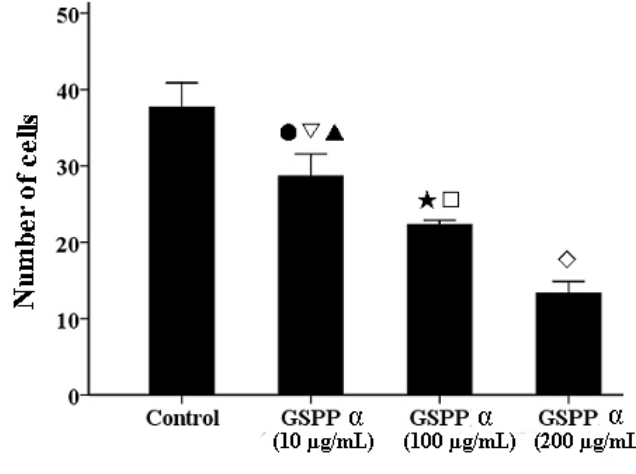
Figure 5. Transwell assay of Gekko sulfated glycopeptides on SMMC-7721 cells. After staining with crystal violet, cells that had penetrated through the chamber were counted using a light microscope. Each bar showed the number of cells that had penetrated through the chamber ( P < 0.001). The values represent means ± SD. ● versus control group, P = 0.001; ▽ versus 100 µg/mL GSPP α , P = 0.01; ▲ versus 200 µg/mL GSPP α , P < 0.001; ★ versus control group, P < 0.001; □ versus 200 µg/mL GSPP α , P = 0.001; ◇ versus control group, P < 0.001. GSPP α : Gekko sulfated glycopeptides.